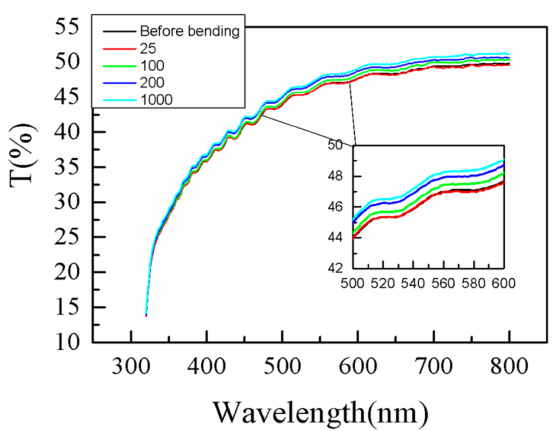
Figure 4. Measured transmittance spectra T of metalized PET substrate covered with polymer film before bends and after each set of